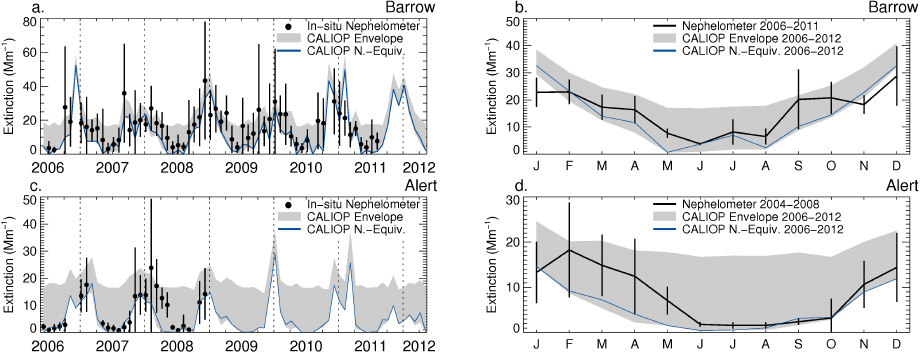
Fig. 5. Comparison between monthly mean CALIOP 532nm and in situ 550nm extinctions at Barrow (top row) and Alert (bottom row). Left panels ( a and c ): Black full circles indicate the in situ monthly mean extinctions, with vertical bars indicating one standard deviation of the daily observations. The in situ extinctions are scaled to ambient RH. The blue line shows CALIOP nighttime-equivalent mean extinction, with grey shading indicating the envelope of CALIOP retrievals (see text). Right panels ( b and d ): CALIOP 2006–2012 climatological mean extinction (blue line: nighttime-equivalent; grey shading: CALIOP envelope) are compared to the in situ seasonal mean extinction (black line). For Barrow the in situ climatological mean extinctions are for year 2006–2011, but for Alert we use years